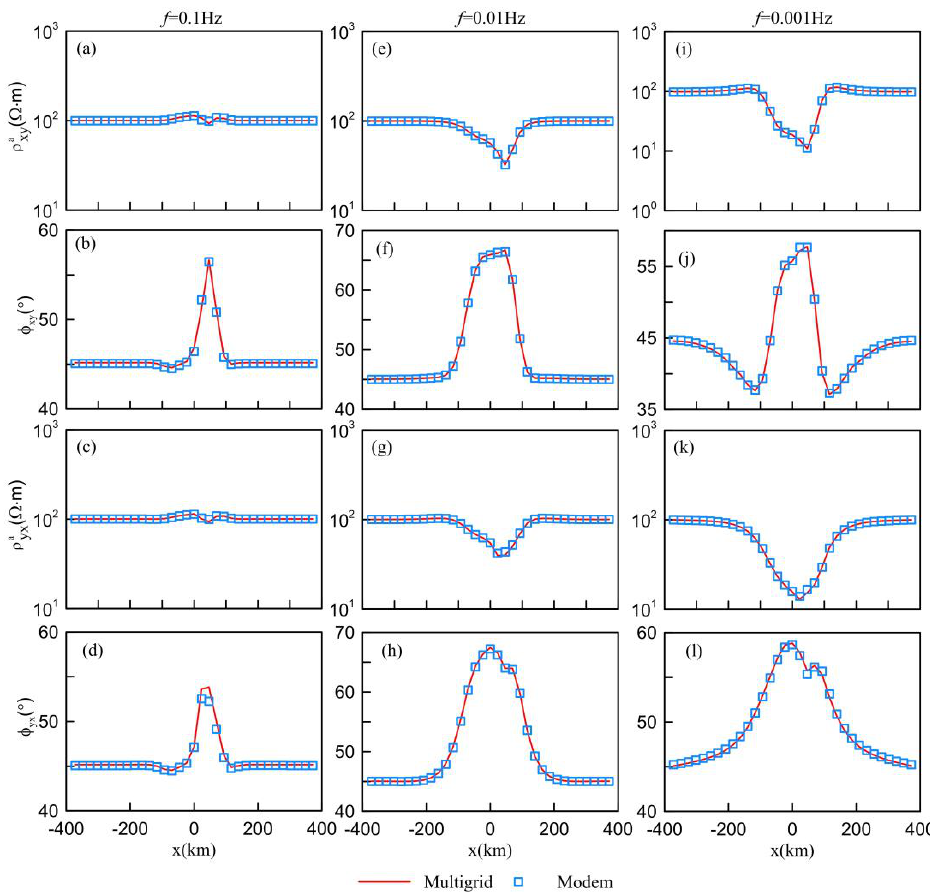
Figure 15. Apparent resistivities and phases calculated for the modified SEG/EAEG salt dome model at frequency of 0.1, 0.01 and 0.001 Hz for the survey line y = 0. ( a ) ( e ) ( i ) and ( b ) ( f ) ( j ) are respectively the apparent resistivities and phases for the frequencies of 0.1, 0.01, 0.001hz in x -polarization mode, while ( c ) ( g ) ( k ) and ( d ) ( h ) ( l ) are respectively the apparent resistivities and phases for the same frequencies in the y -polarization mode. The red lines display the results of our MG algorithm, while the blue squares display the results calculated by ModEM developed by Kelbert et al. [14] .